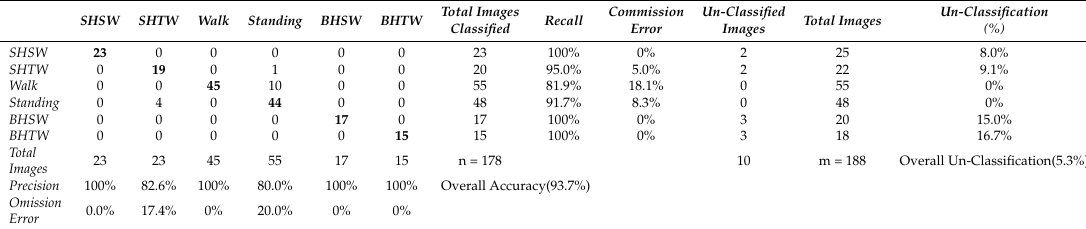
Table 3. Classification matrix for Denis images.